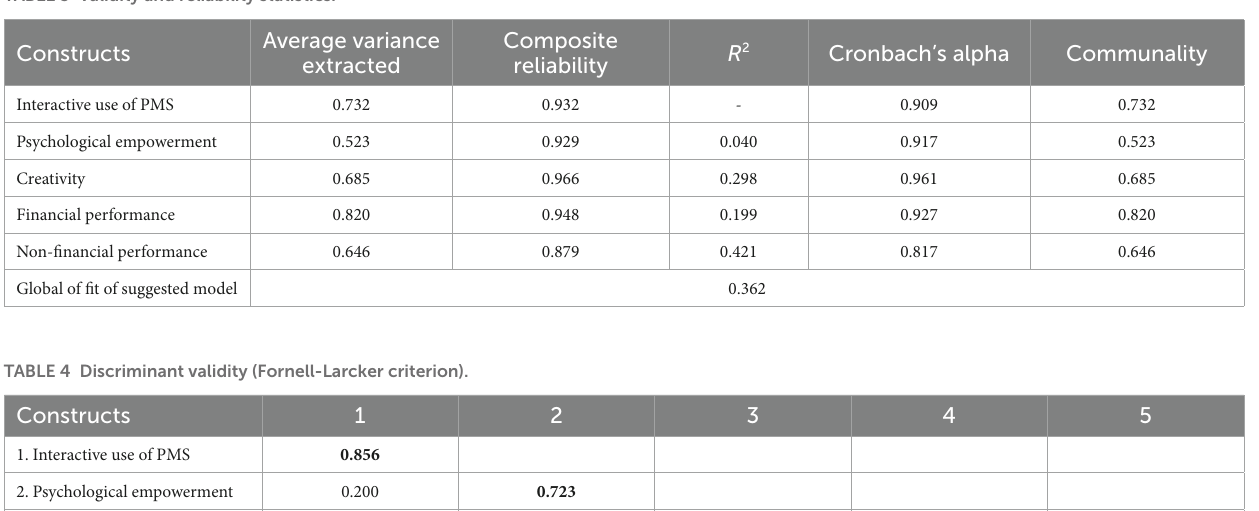
TABLE 3 Validity and reliability statistics.